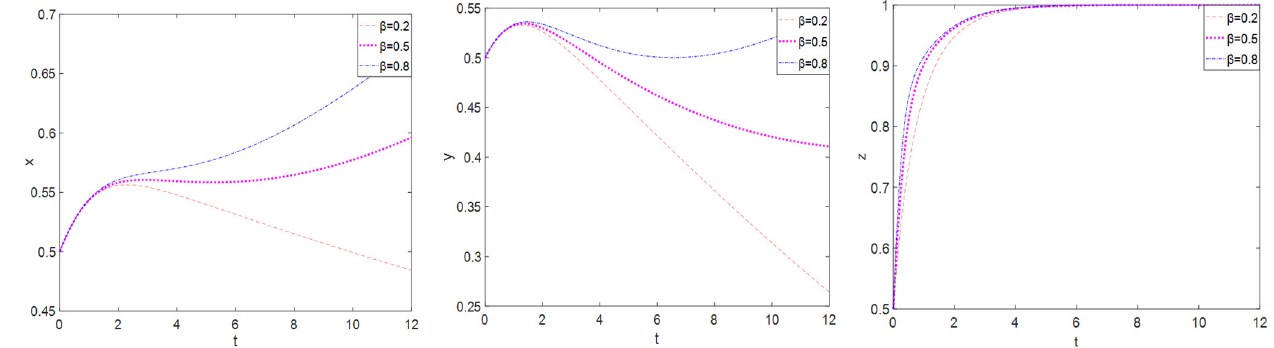
Figure 2. The impact of government infrastructure construction on the behavior of suppliers of col- laborative innovation in green building projects of construction enterprises according to evolutionary game.